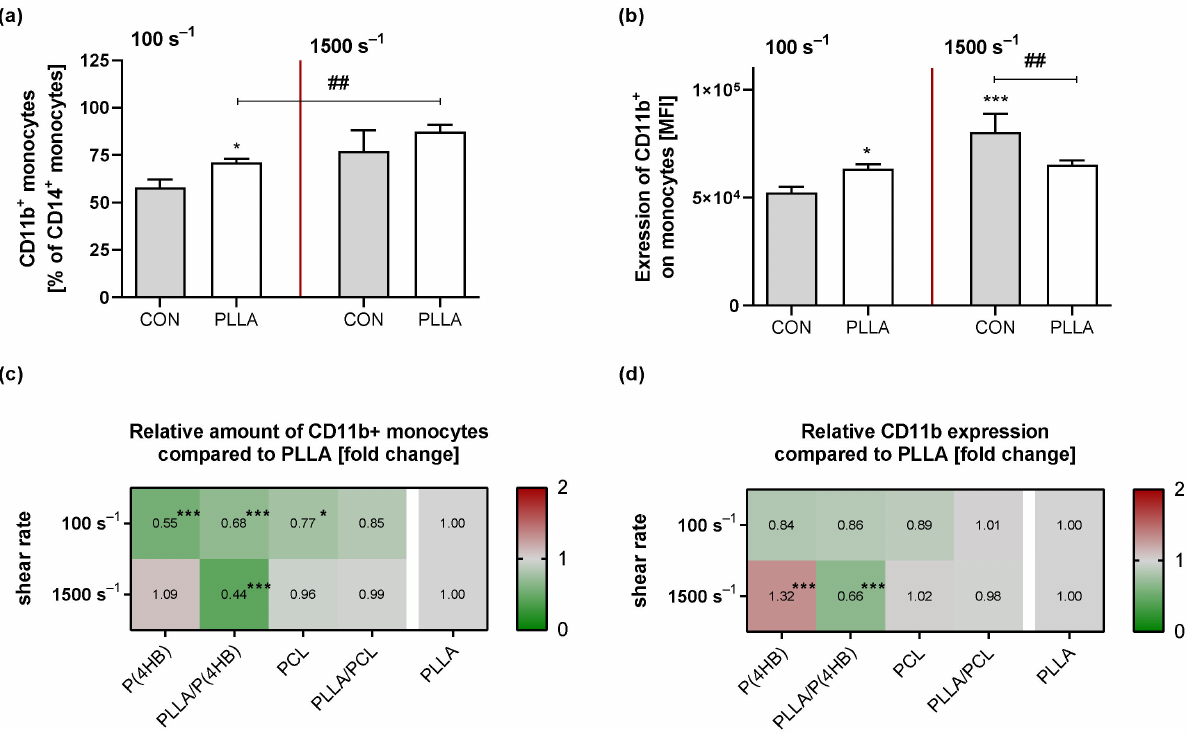
Figure 5. Monocyte activation on polymer surfaces under hemodynamic forces. Human peripheral blood mononuclear cells (PBMCs) were isolated from an in-line filter system for leukocyte filtration and exposed to the indicated polymer surfaces using shear rates of 100 s − 1 and 1500 s − 1 . Subsequently circulating PBMCs were characterized regarding their CD11b expression by FACS analysis. ( a ) Bars show mean proportion of CD11b+ monocytes ± SD after exposure to the indicated surfaces compared to the control (CON). ( b ) Bars show mean fluorescence intensity (MFI) of CD11b+ monocytes ± SD compared to the control. ( c / d ) To visualize the effect of the different polymers, heat maps show the relative mean compared to PLLA. All experiments were repeated 5 times. Significances in regard to the corresponding control are indicated with * p < 0.05, and *** p < 0.001. Significances between groups are indicated with ## p <